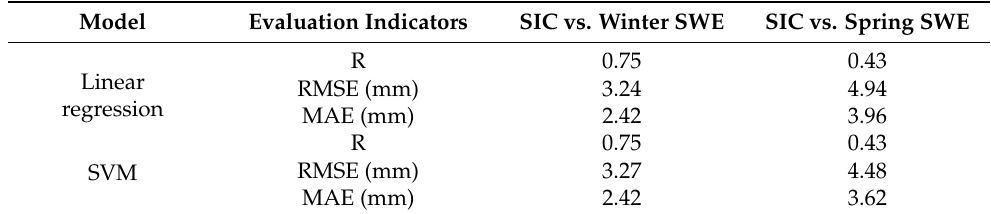
Table 3. Comparison of forecasted values and actual results of Eurasian SWE in autumn and winter from 2000 to 2018.